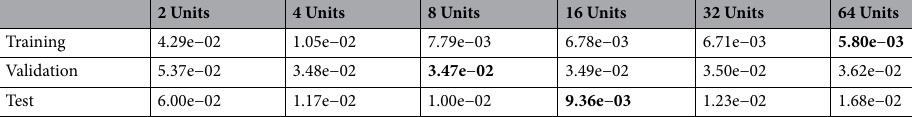
Table 2. The average RMSE of ten simulations obtained with the GRU model, for different sizes of the recurrent layer. Significant values are given in